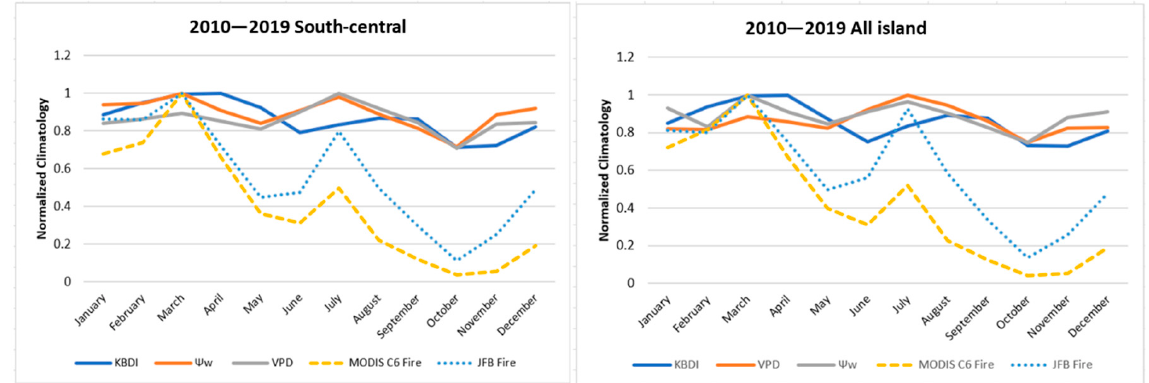
Figure 4. ( Left panel ) Normalised climatologies of VPD, KBDI, Ψ w , MODIS and JFB for south-central Jamaica (Manchester, Clarendon & St Catherine). ( Right panel ) As for the left panel but for the entire island. Base period is 2010–2019. Bushfire potential indices derived using ERA5 data.